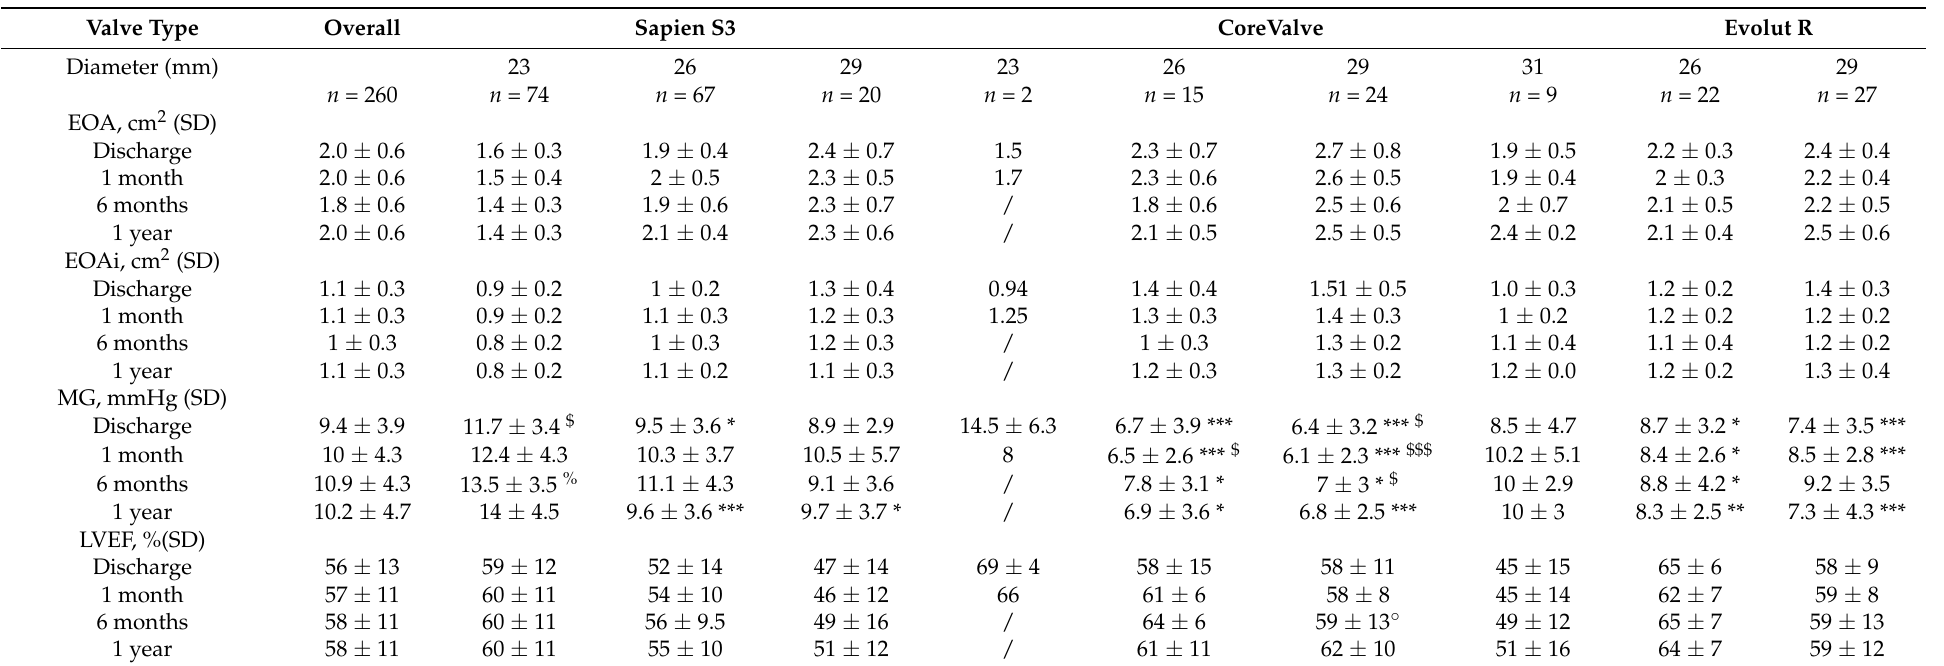
Table 3. Evolution of EOA, EOAi, MG, and LVEF values at